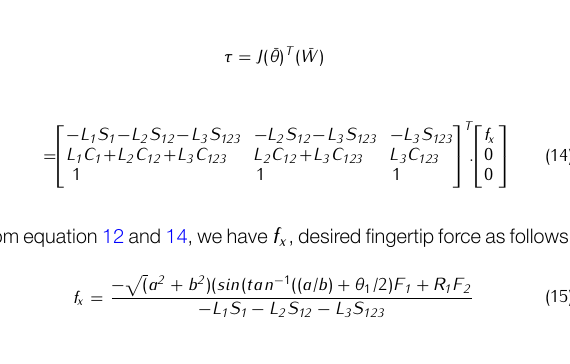
Grasp Recognition